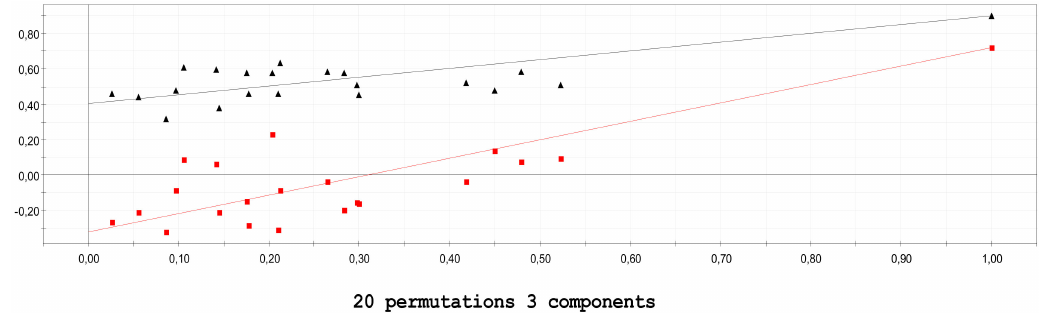
Figure 2. Internal validation test with 20 permutations, for model P app . Intercepts: R 2 = (0.0, 0.405) marked black, Q 2 = (0.0, − 0.32) marked